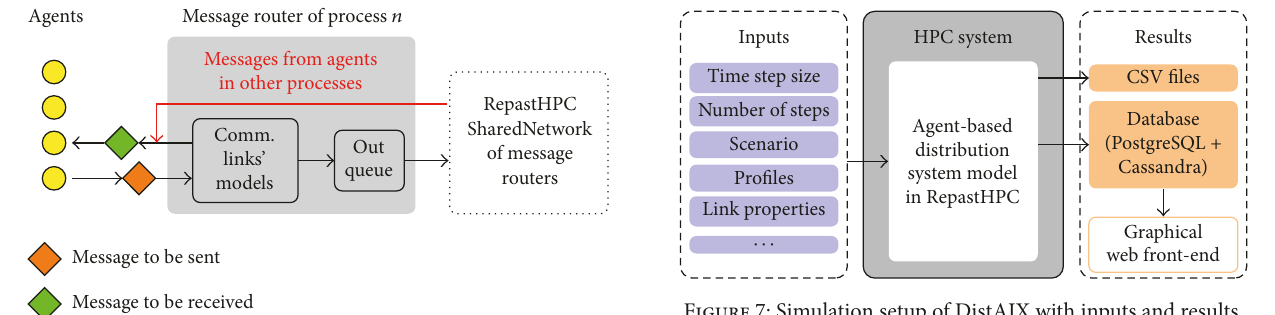
Figure 7: Simulation setup of DistAIX with inputs and